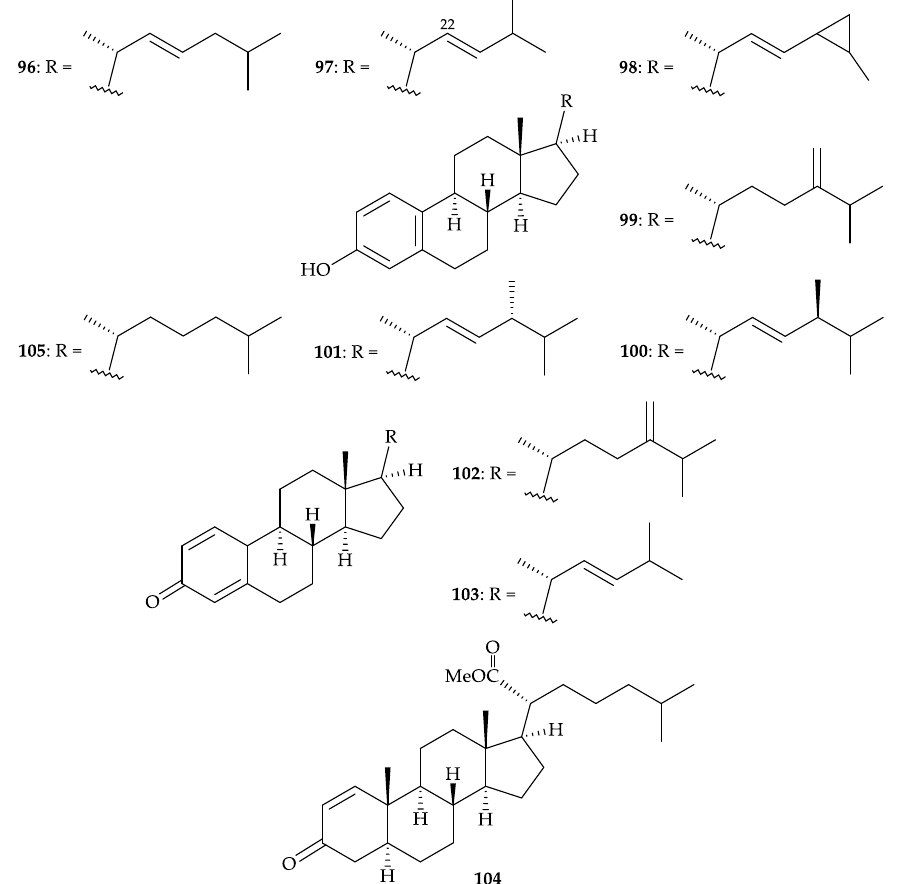
Figure 16. Structures of (22 E )-19-norcholesta-1,3,5,22-tetraen-3-ol ( 96 ), (22 E )-19,24-dinor- cholesta- 1,3,5,22-tetraen-3-ol ( 97 ), (22 E )-24,26-cyclo-19-norcholesta-1,3,5,22-tetraen-3-ol ( 98 ), 24-methylene-19-norcholesta-1,3,5,22-tetraen-3-ol ( 99 ), (22 E ,24 S )-24-methyl-19-norcholesta-1,3,5 (10),22-tetraen-3-ol ( 100 ), (22 E ,24 R )-24-methyl-19-norcholesta-1,3,5,22-tetraen-3-ol ( 101 ), 24- methylenecholesta-1,4,22-trien-3-one ( 102 ), (22 E )-24-cholesta-1,4,22-trien-3-one ( 103 ), methyl spongoate ( 104 ), and 19-norcholesta-1,3,5-trien-3-ol ( 105 ).